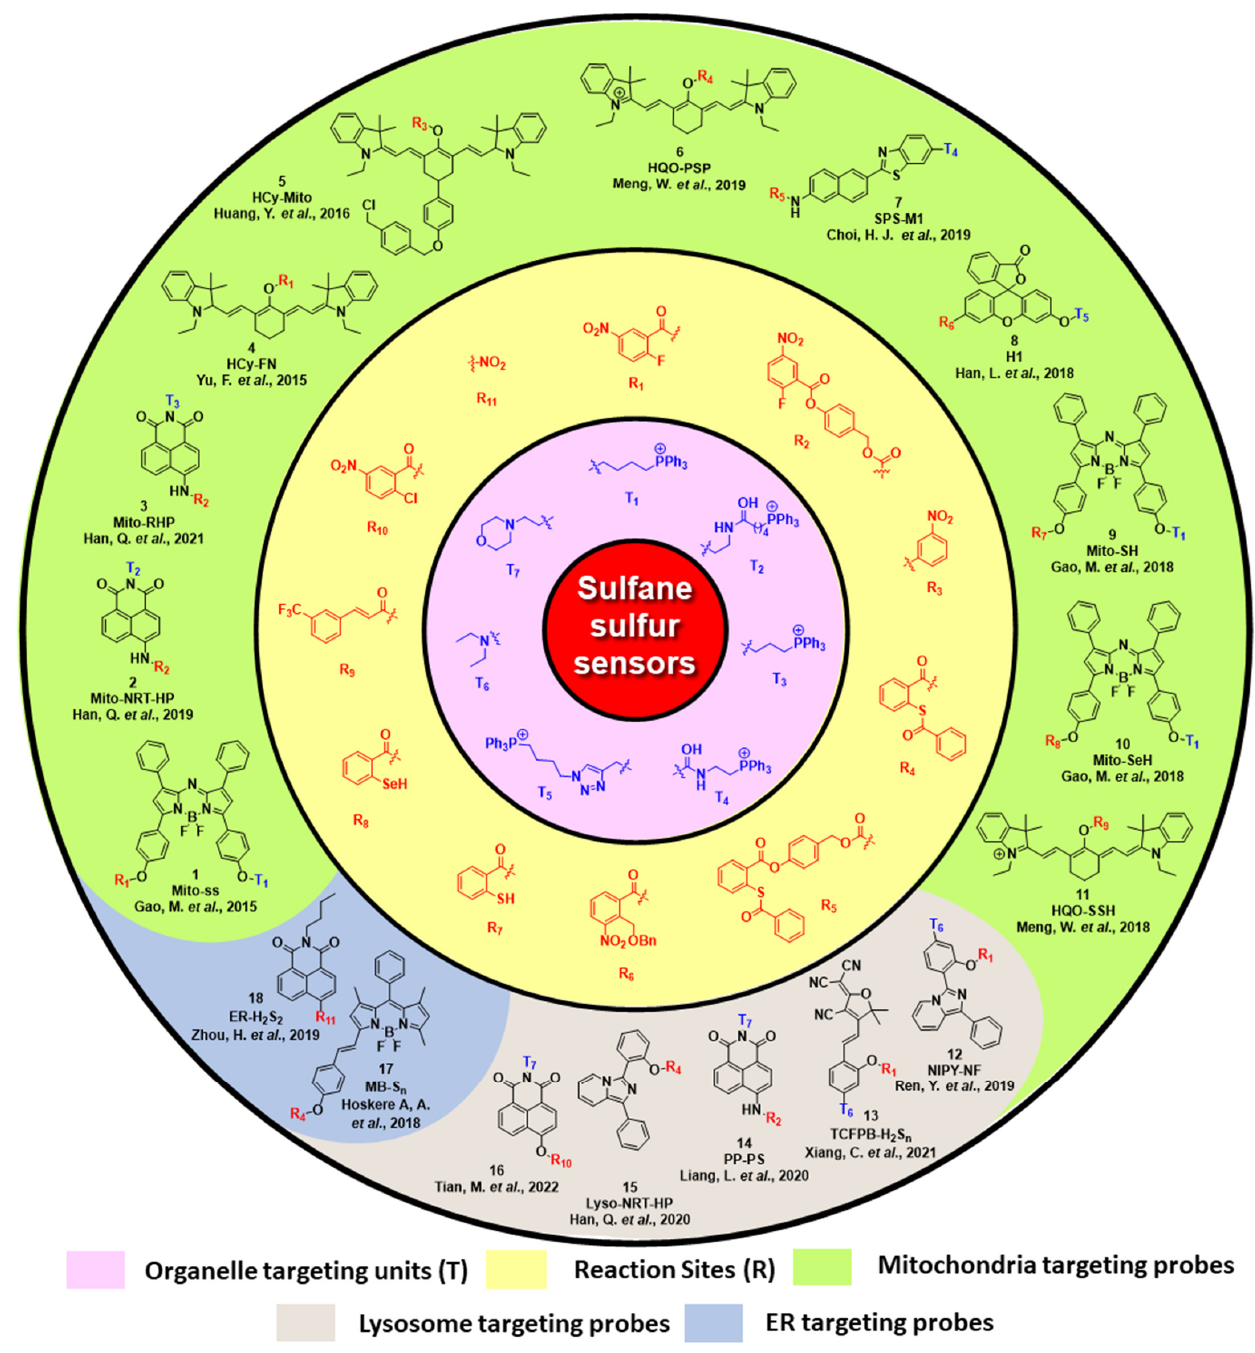
Figure 1. A summary of reported organelle-targeted fluorescent probes for sulfane